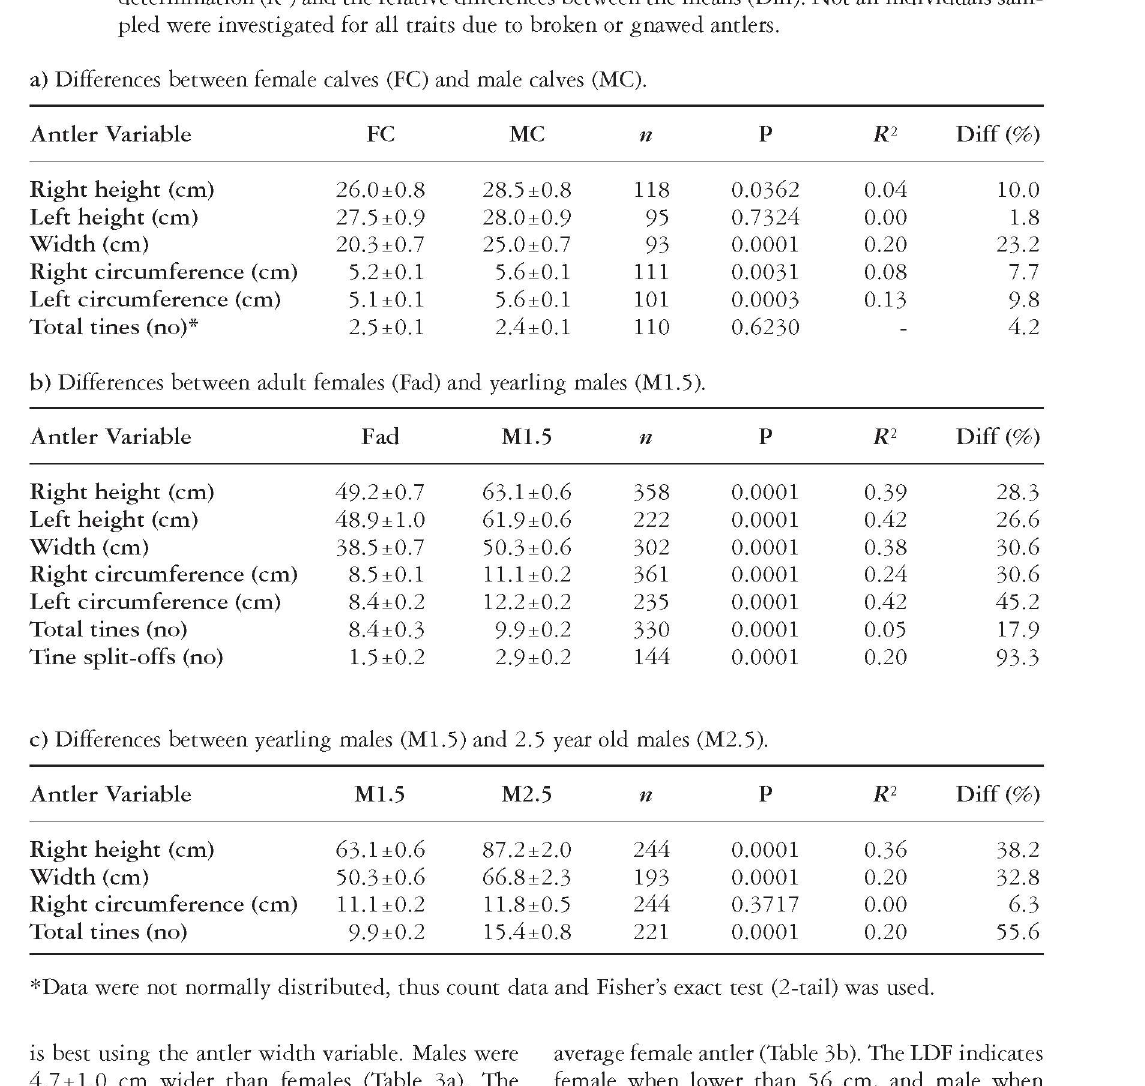
Table 3. A N O VA analysis of the differences between a) male calves (MC) and female calves (FC), b) adult females (Fad) and yearling males (M1.5), and c) yearling males (M1.5) and 2.5 year-old males (M2.5). Values are mean ± standard errors, sample size (n), significance level (P), coefficient of determination (R 2 ) and the relative differences between the means (Diff). Not all individuals sam¬ pled were investigated for all traits due to broken or gnawed